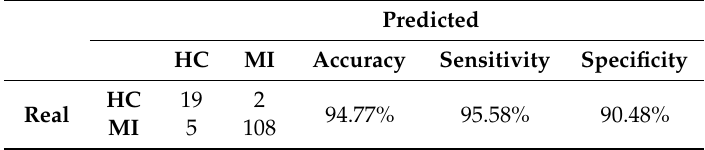
Table 3. The performance of Bi-LSTM with the heartbeat-attention mechanism (Experiment 2).